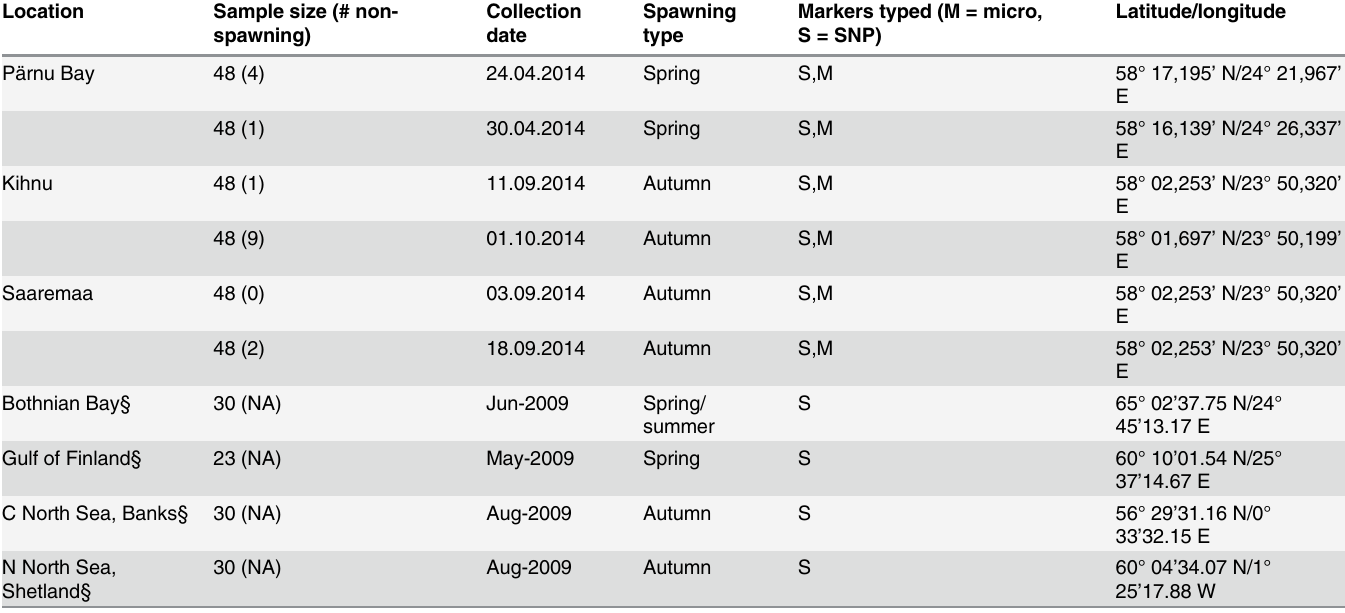
Table 1. C . harengus samples in the analysis. Numbers of genotyped fish; numbers in brackets show numbers of fish per sample in pre-spawning stage (i.e. non-spawning). Location Sample size (# non-